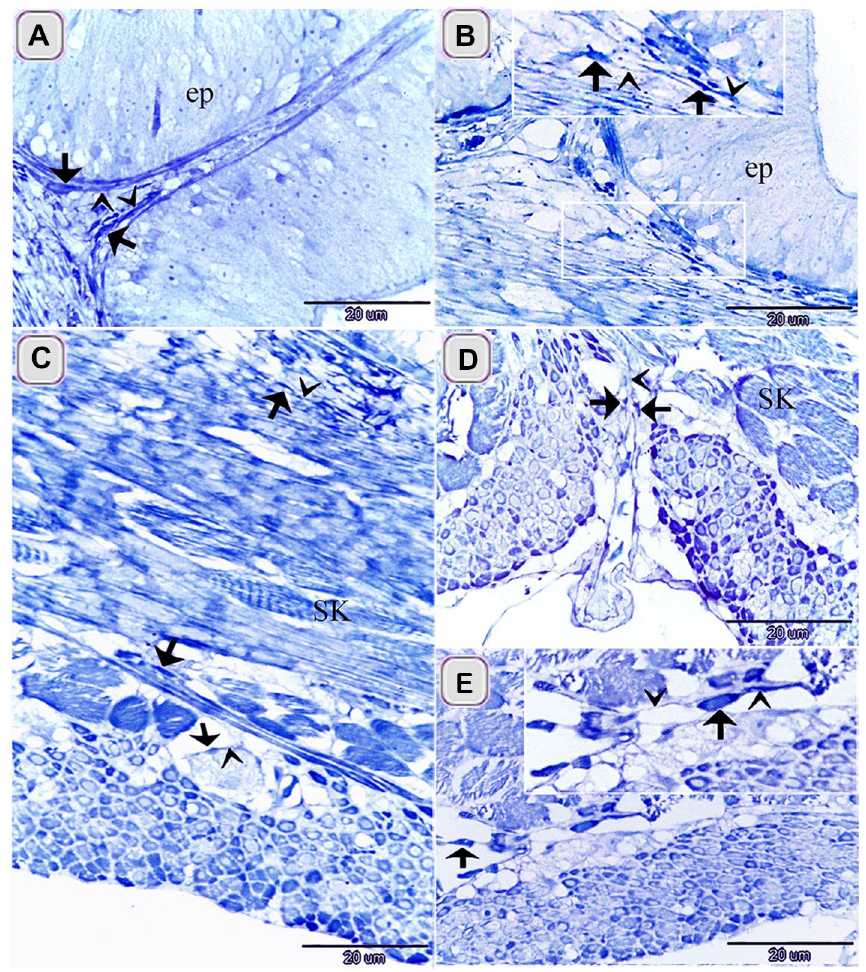
Figure 1. Identification of TCS in the intestinal bulb of Grass carp using methylene blue. Semi thin sectioned of the intestinal bulb stained by methylene blue. The cell body of TCs (arrows), telopodes (arrowheads) under the epithelium ( A ), in the lamina propria ( B ) and in between the muscular fibers ( C – E ). Note epithelium (ep), skeletal muscles (SK) in the initial part of intestinal